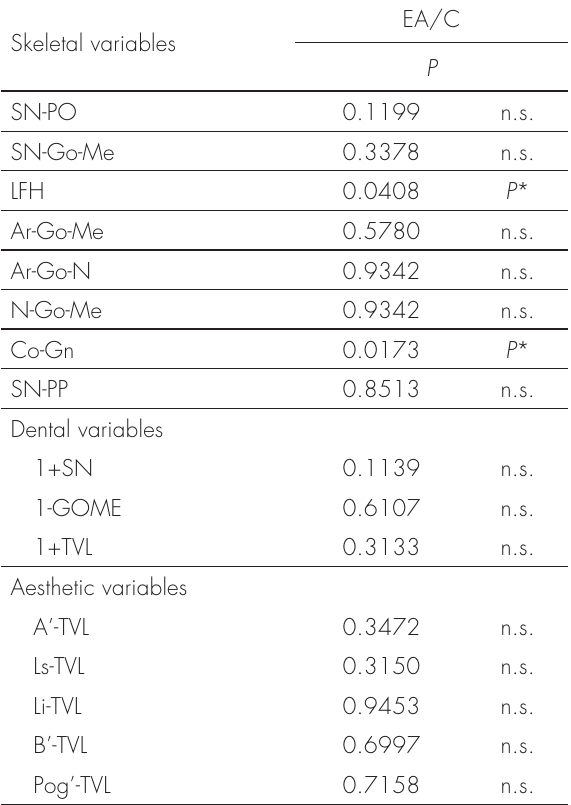
Table III. Comparison of skeletal, dental, and aesthetic variables between two groups.